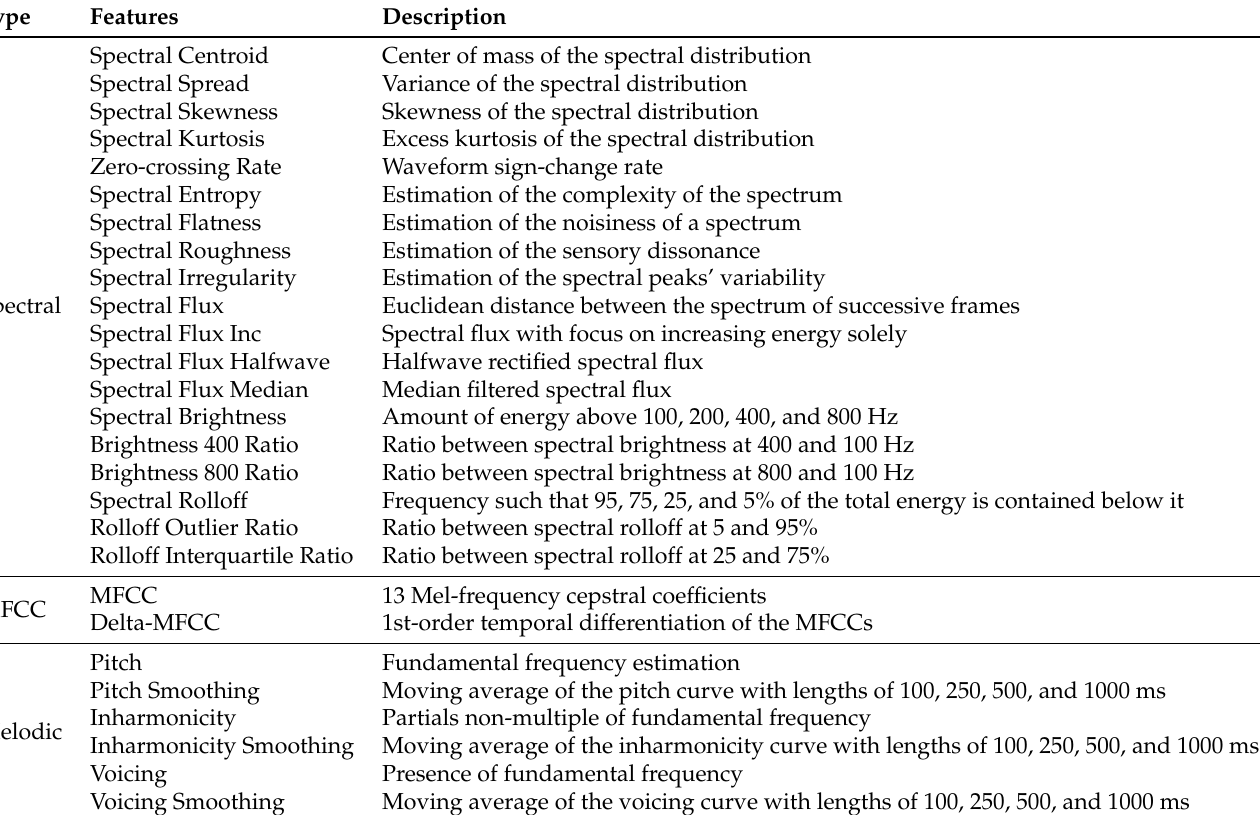
Table 5. Small description of each